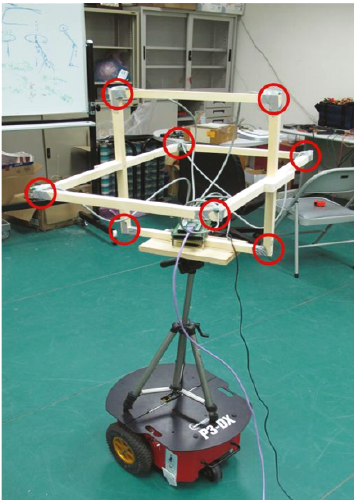
Figure 6: Digital microphone array mounted on the